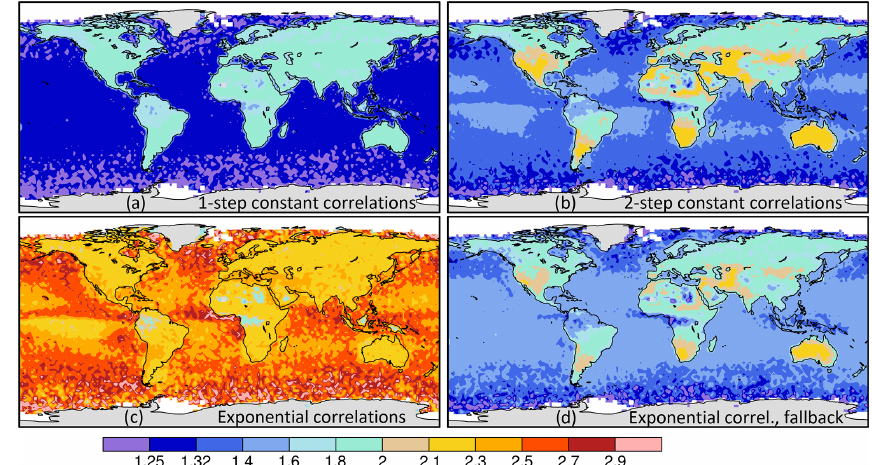
Figure 8. The ratio of the measurement information, defined as σ − 2 , for the X CO the measurement information of the 2s average values shown in Fig. 7, computed across September 2014–October 2020 (annual, not half- yearly). The four correlation models are (a) the one-step and (b) the two-step constant correlation models and the exponential correlation model using (c) Eq. (8) and (d) Eq. (28) to calculate the